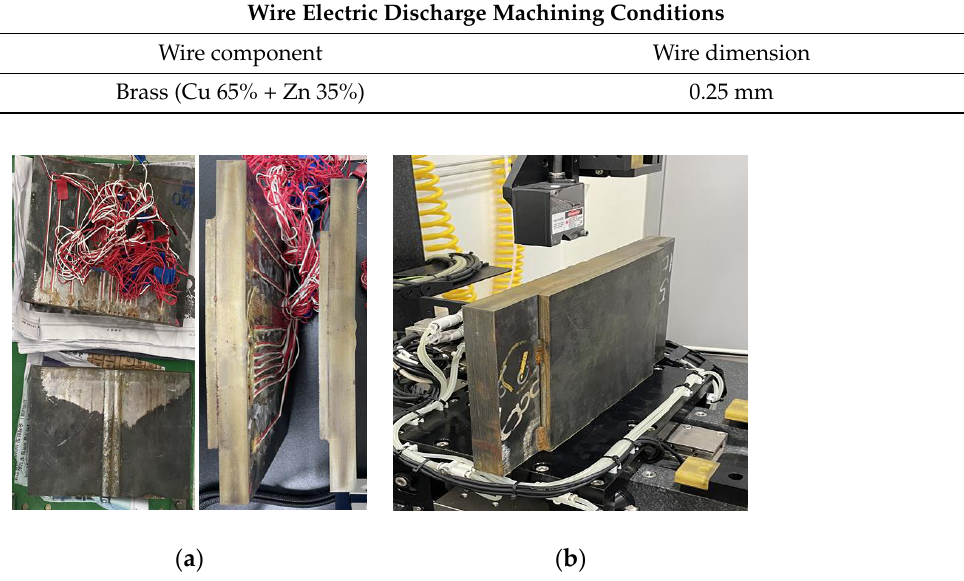
Figure 8. Contour method to measure the welding residual stress. ( a ) WEDM cutting process of specimens; ( b ) contour method process of specimens.